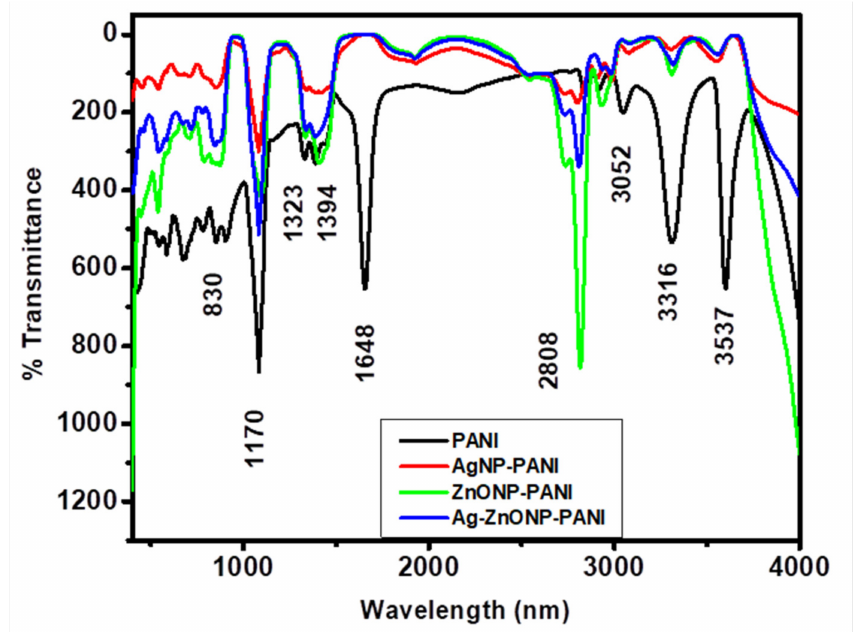
Figure 3. FTIR spectra of PANI (black line), AgNP-PANI (red line), ZnONP-PANI (green line), and Ag–ZnONP-PANI (blue line)